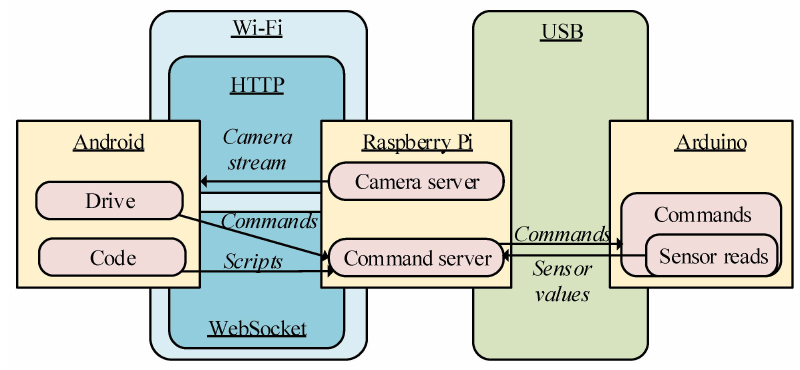
Figure 2. Communication scheme of the